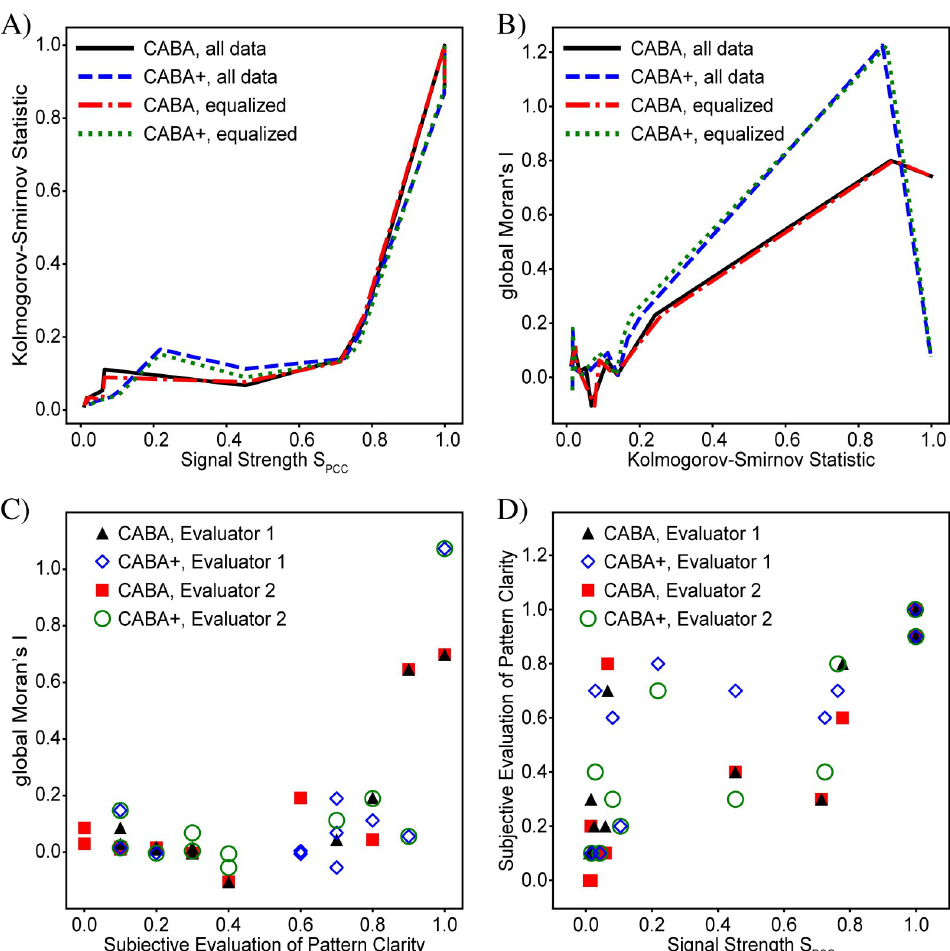
Fig 16. Comparison of statistical metrics. (A) Comparison of regression analysis with Kolmogorov-Smirnov analysis regarding presence of a signal. At low values and at high values, the two metrics compare very well to each other, but deviate noticeably for intermediate values. Based on visual inspection of the frequency-comparison plots in Fig 13 and the angle-histogram plots in Fig 14, the Pearson-correlation-coefficient-based metric appears to do a better job of quantifying the signal strength for the intermediate cases. Four plots are displayed. The black-solid and blue-dashed lines correspond to the data presented in the analyses above, for the CABA and CABA+ extents, respectively. The two curves show a similar but not identical behavior, with the biggest difference occurring for the local vs foreign user case (S PCC = 0.22 vs 0.07 and KSS = 0.17 vs 0.09 for CABA+ and CABA, respectively). This discrepancy suggests that urban vs rural location has a greater impact on foreign users than downtown vs not-downtown within the city. The red-dot- dash and green-dotted curves are the equivalent of the previous two curves, except that the target and reference tweet counts have been equalized using randomized filtering of the larger set (see figures in S5 File). The equalized and non- equalized curves are nearly identical to each other, showing that the asymmetry in the number of tweets does not strongly affect the conclusions (B) Comparison of global Moran’s I vs the Kolmogorov-Smirnov statistic. In general, higher values of global Moran’s I are found for larger values of the Kolmogorov-Smirnov statistic, implying that (for these two metrics), clear patterns tend to go hand-in-hand with strong signals. This trend is broken for the last point corresponding to the location names case where the number of bins containing tweets was much lower than for any other case. This sparsity results in occupied bins tending to be disconnected, which is problematic for calculating global Moran’s I using nearest-neighbor weighting. (C) Comparison between global Moran’s I and a subjective evaluation of the pattern clarity. Both human evaluators independently judged the presence of a clear pattern on a scale from 0 to 1. The comparison shows first, that the two subjective judgements agree very well with each other, and second, that while global Moran’s I agrees with the subjective judgement at each end of the scale, it tends to undervalue the presence of a pattern relative to the subjective judgement for intermediate values. (D) Comparison of the subjective pattern evaluation vs the Pearson-correlation-coefficient-based signal strength metric. The plot shows (for these two metrics) that pattern clarity tends to correlate with signal strength, with especially good agreement at either end of the scale. As mentioned in the analyses above, however, there are also cases of clear patterns without strong signals and strong signals without clear